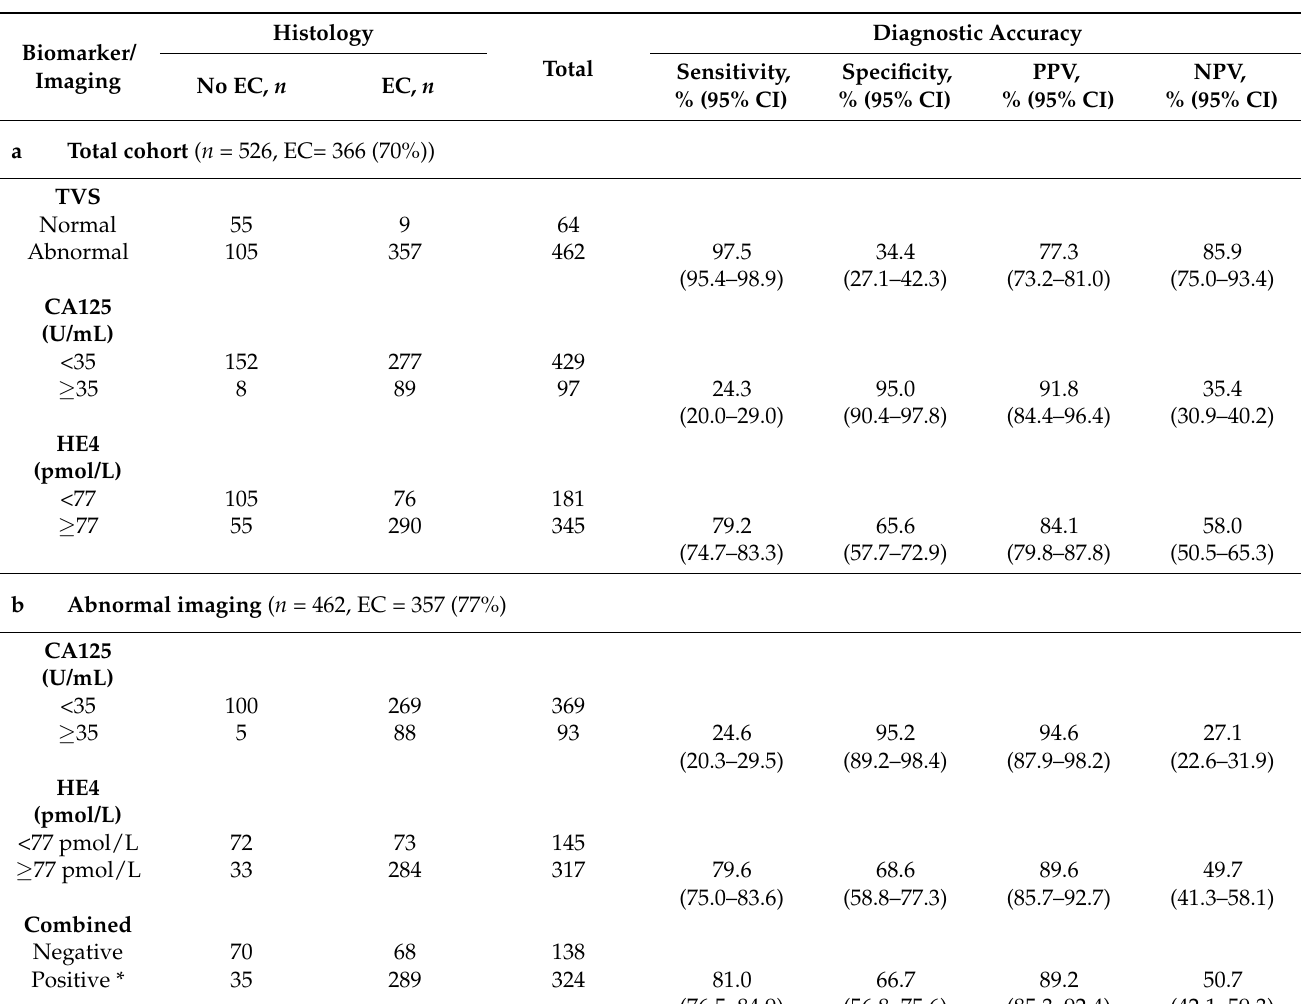
Table 6. Diagnostic accuracy of TVS imaging and serum biomarkers for the detection of endome- trial